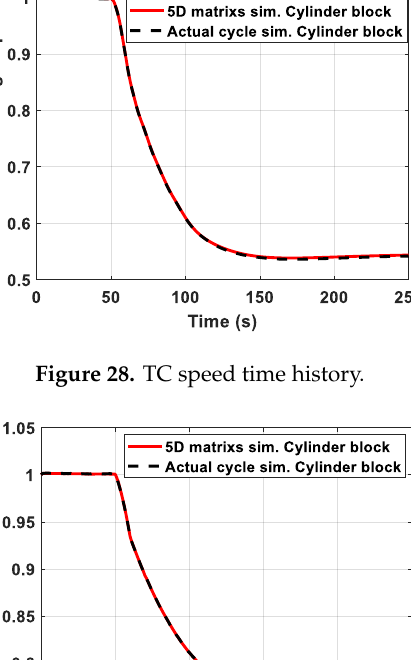
Figure 27. Turbine inlet temperature time history.